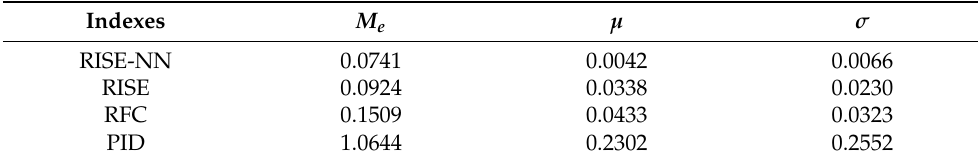
Figure 14. Control inputs of RISE-NN-TAS with thrust allocation. Table 2. Tracking performance indexes of the four controllers in case 1.